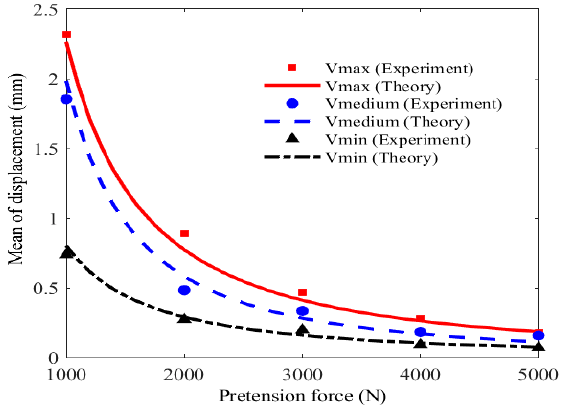
Figure 16. Mean value of displacement versus pretension force.